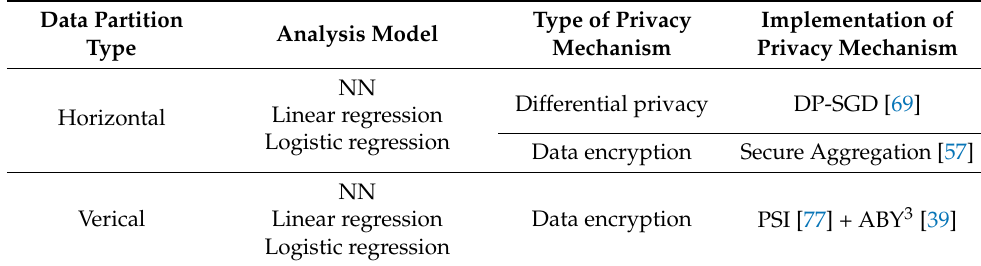
Table 6. Privacy mechanisms implemented in PFL